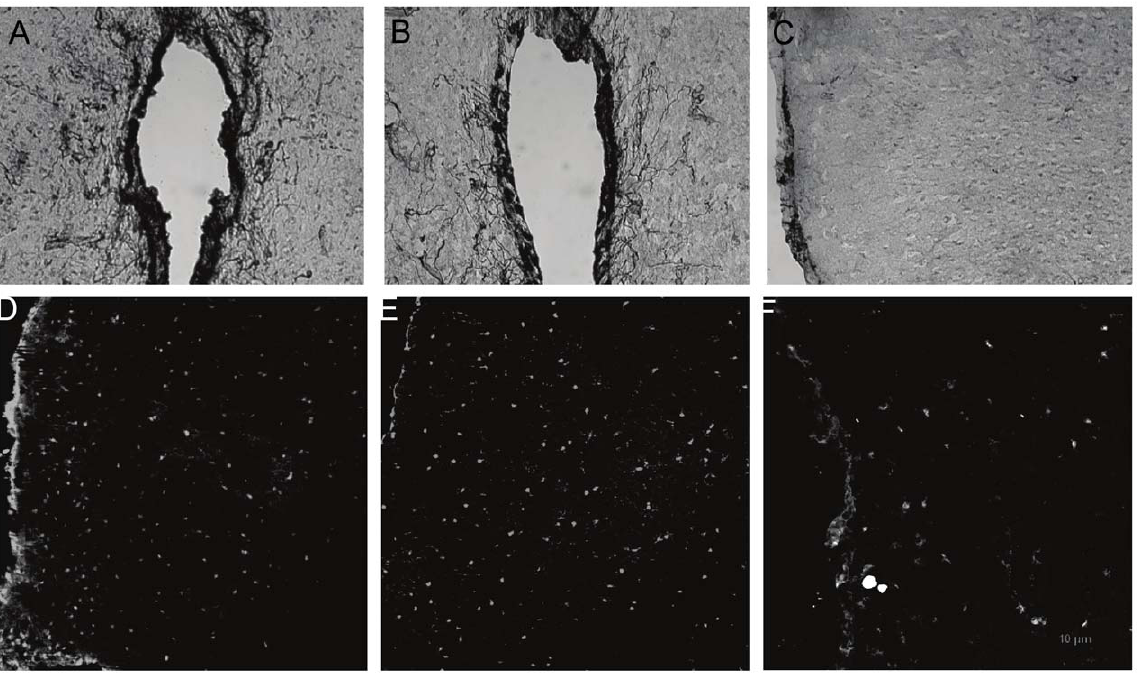
Figure 3. Vimentin-ir cells within the Cg2 and MPOA of cycling and postpartum animals. No significant changes were observed within Cg2 (A), however, vimentin-ir remained decreased in the MPOA (B) after 24 hours postpartum, suggesting a decrease in immature radial glia in this area during the postpartum period. Asterisks denote a significant difference (p , .05) from all other groups. (Cg2: cycling n=3, all other groups, n=4 MPOA: n=4 for all groups)